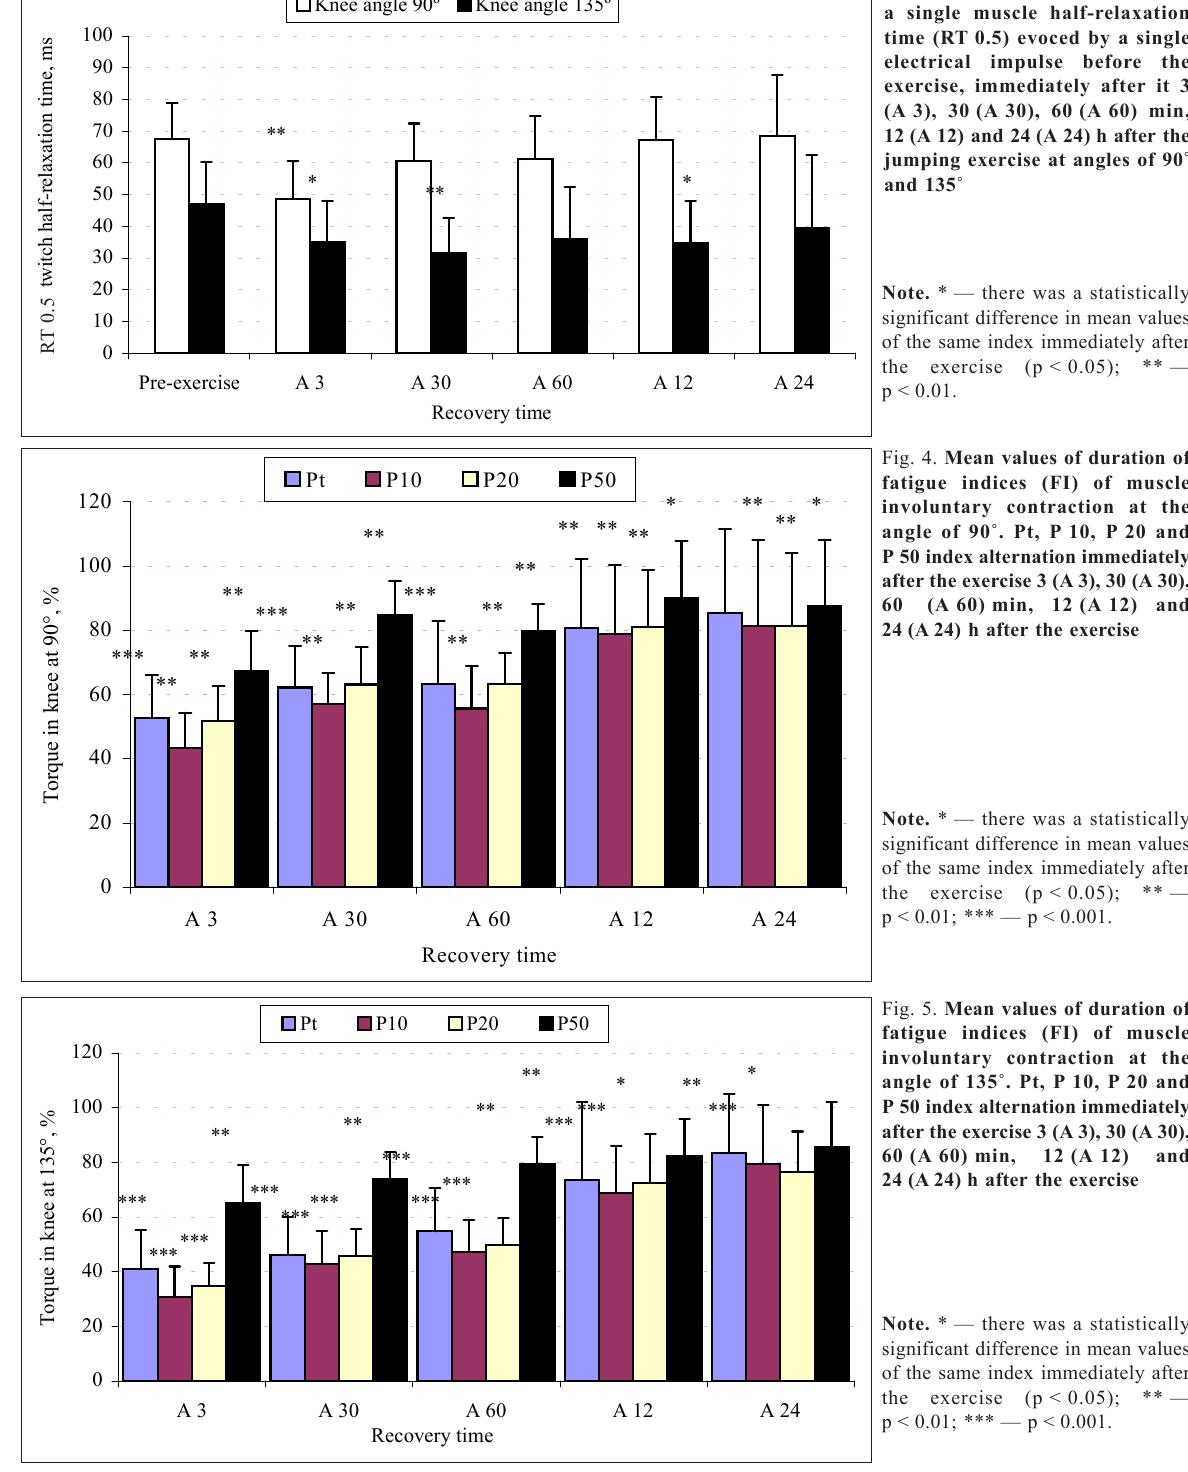
Fig. 3. Mean values of duration of a single muscle half-relaxation time (RT 0.5) evoced by a single electrical impulse before the exercise, immediately after it 3 (A 3), 30 (A 30), 60 (A 60) min,